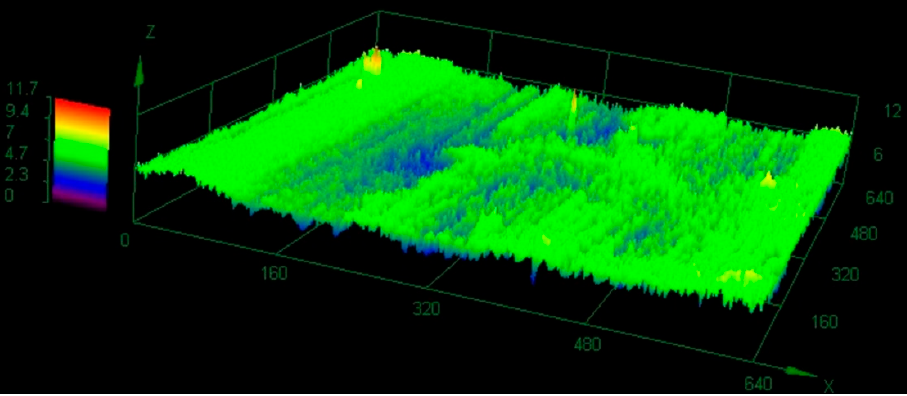
Figure 17. The 3D mapping of the friction surface of the composite tested in the water